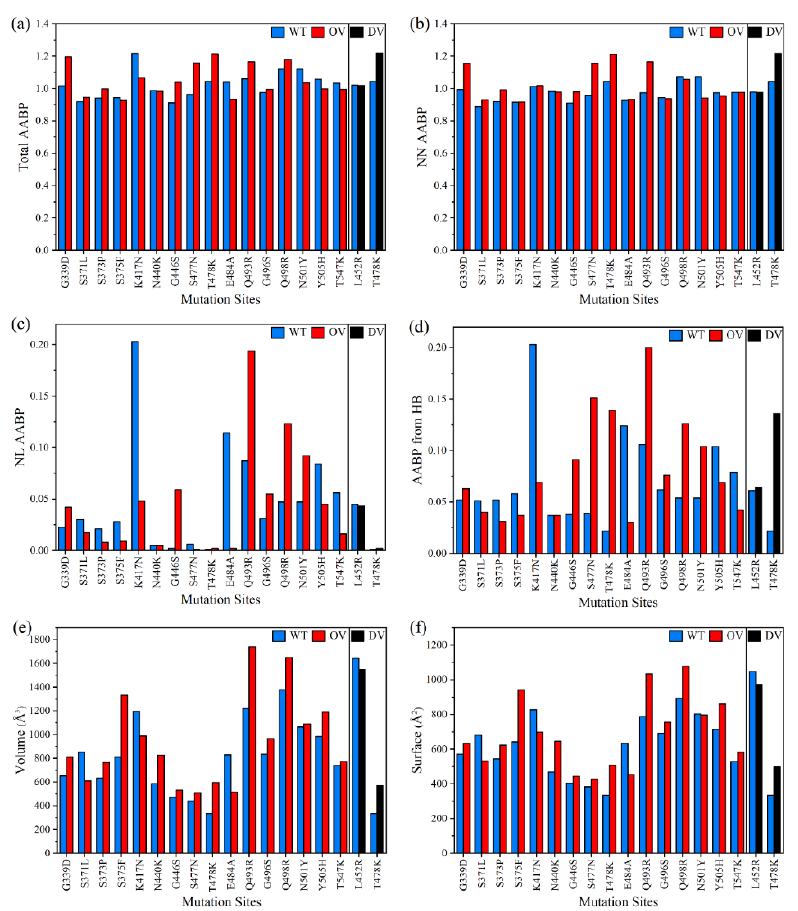
Figure 2. Comparison of 2 DV and 16 OV mutations with their corresponding WT sites of RBD-SD1 model in term of. ( a ) Total AABP, ( b ) NN AABP, ( c ) NL AABP, ( d ) AABP from HB, ( e ) Volume, ( f ) Surface area.